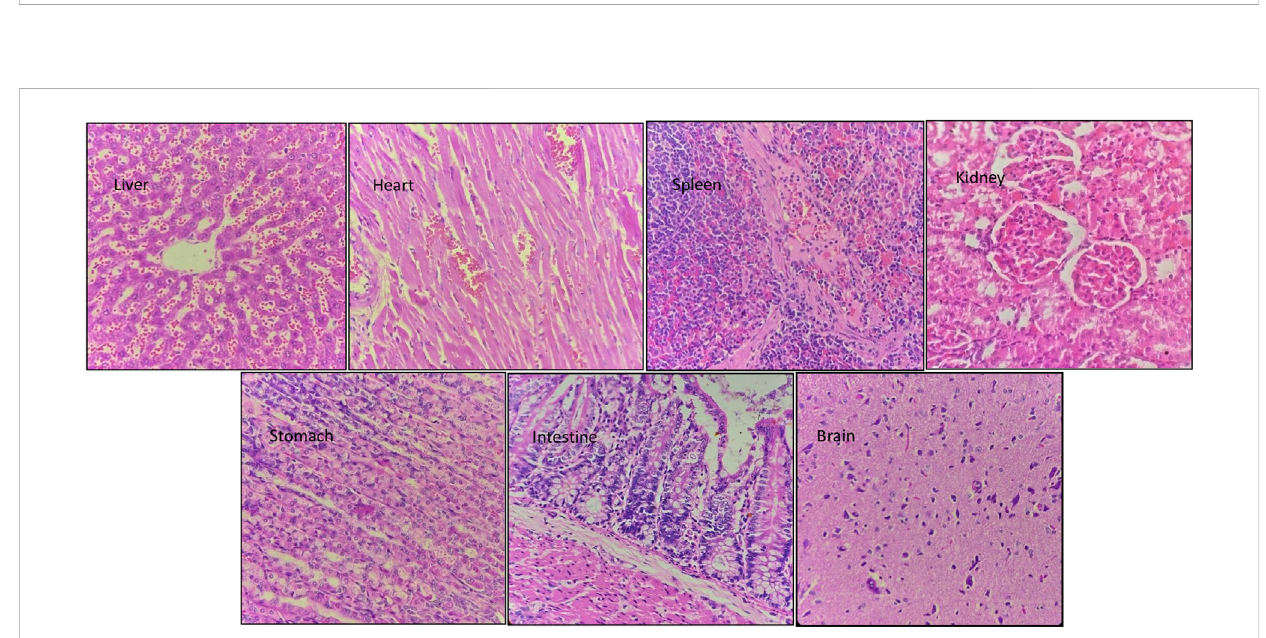
FIGURE 6 Hematoxylin and eosin-stained sections of vital organs harvested from Group C animals (300 mg/kg) after 14 days of oral NVA-IT administration.